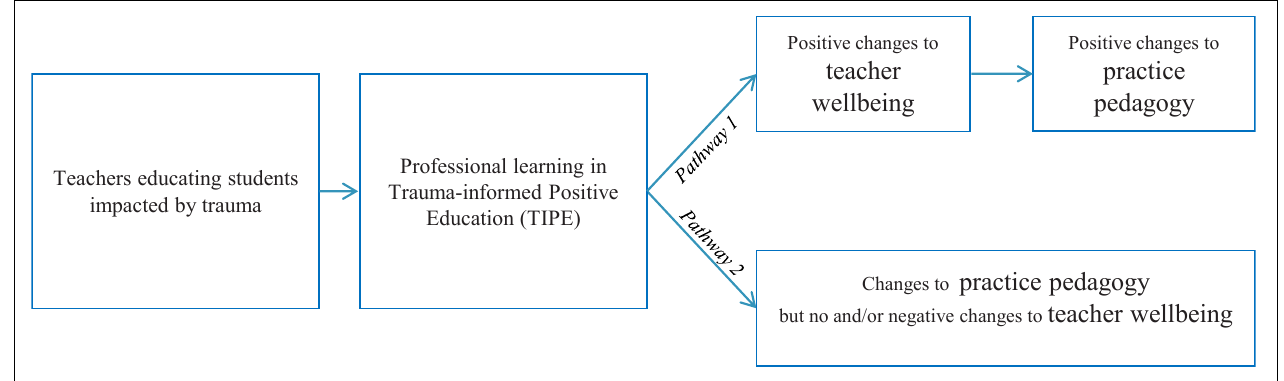
FIGURE 1 | Teacher perspectives on the impacts of Trauma-Informed Positive Education (TIPE).